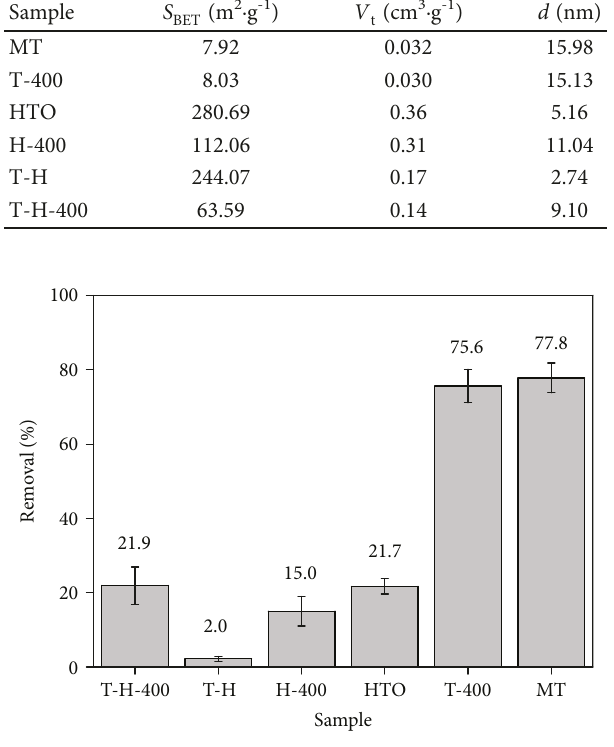
Figure 8: The e ff ect of the adsorption on the degradation of 2,4-DCP solution by all samples in the dark.